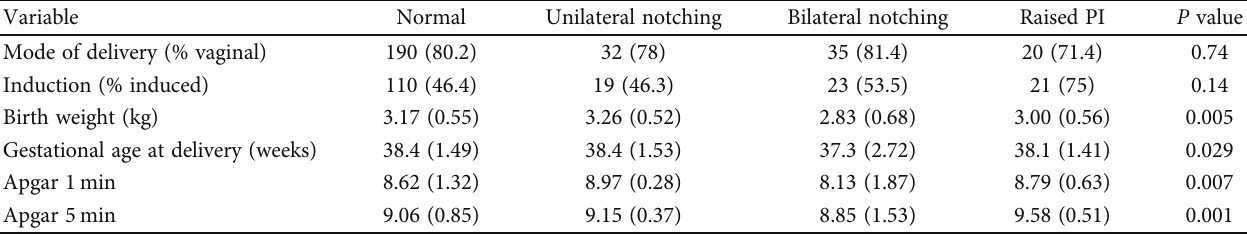
Table 2: Association of normal and abnormal uterine artery Doppler with perinatal outcomes.